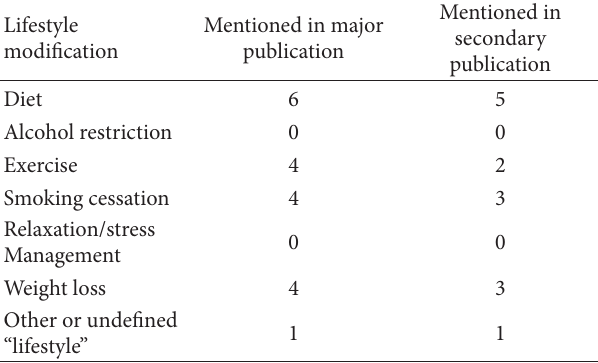
Table 1: Characteristics of articles cited in a leading selected Cochrane review (Wright and Musini [8] that mentioned lifestyle